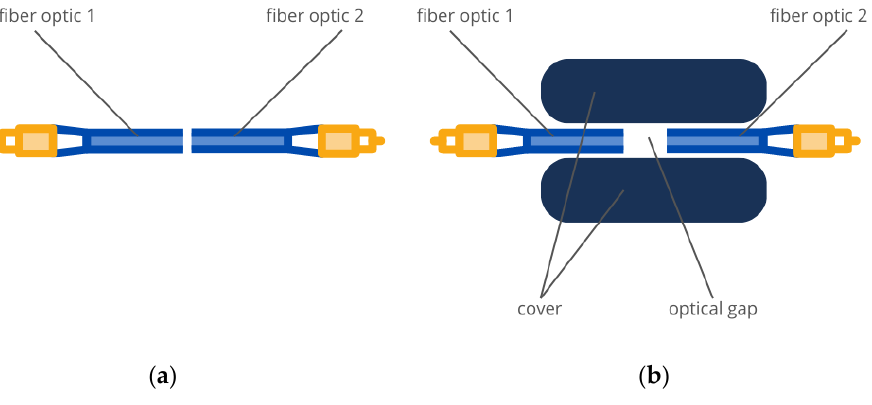
Figure 8. Optical slit structure: ( a ) internal, ( b ) external [78].